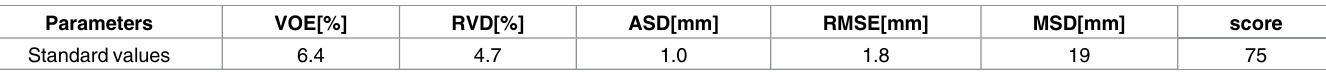
Table 4. The set five evaluation standard